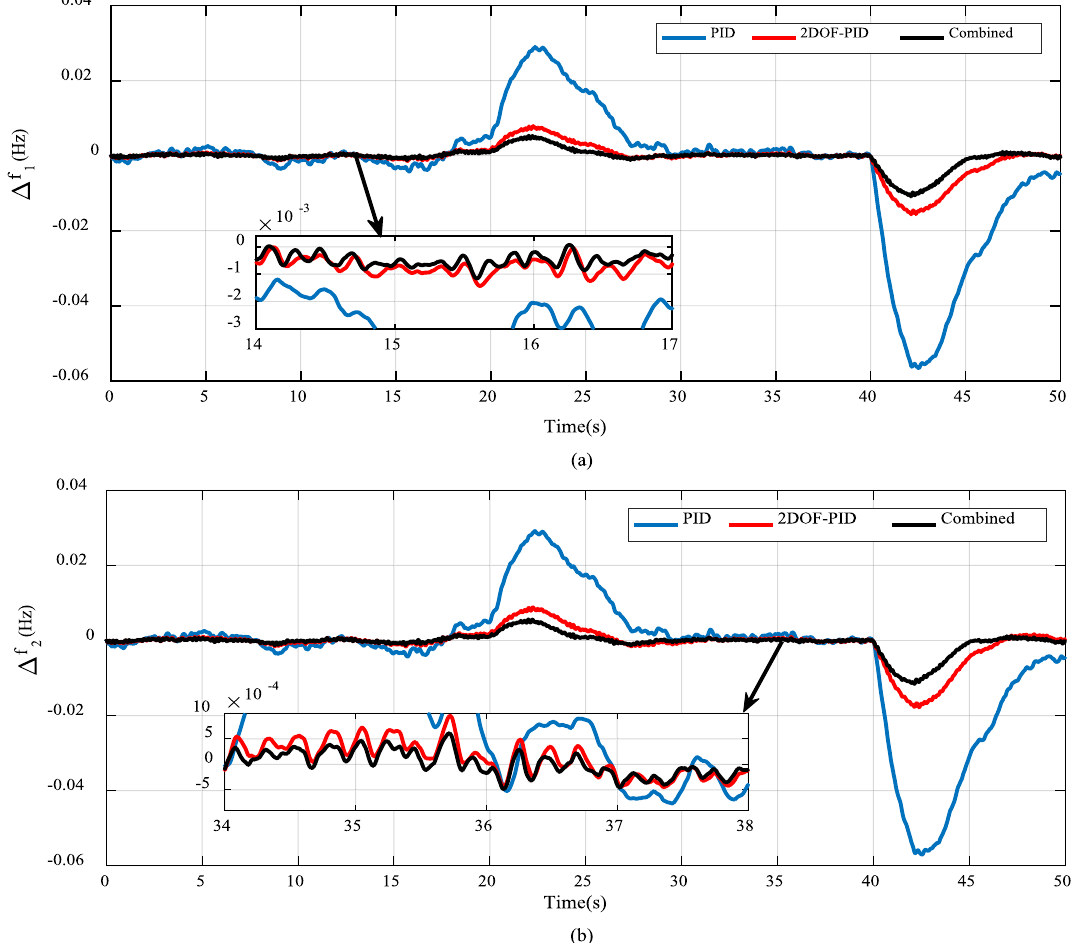
Fig. 8 Frequency disturbances generated with secondary controllers when both areas are equipped with wind penetration (wind power variation in both area I and area II with 6% increase at 20 s and 12% decrease at 40 s without SLP). a Area I; b area